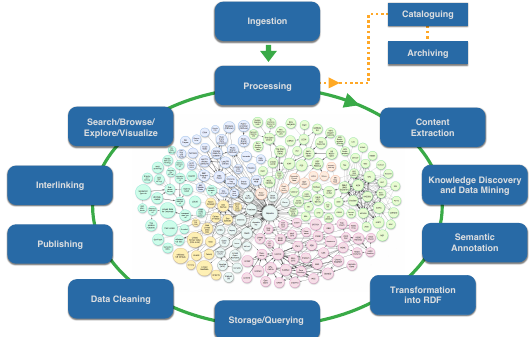
Figure 6. The lifecycle of Linked Earth Observation